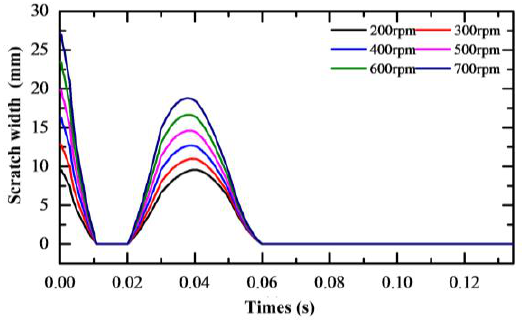
Figure 18. Scratch damage width with different workpiece speeds.